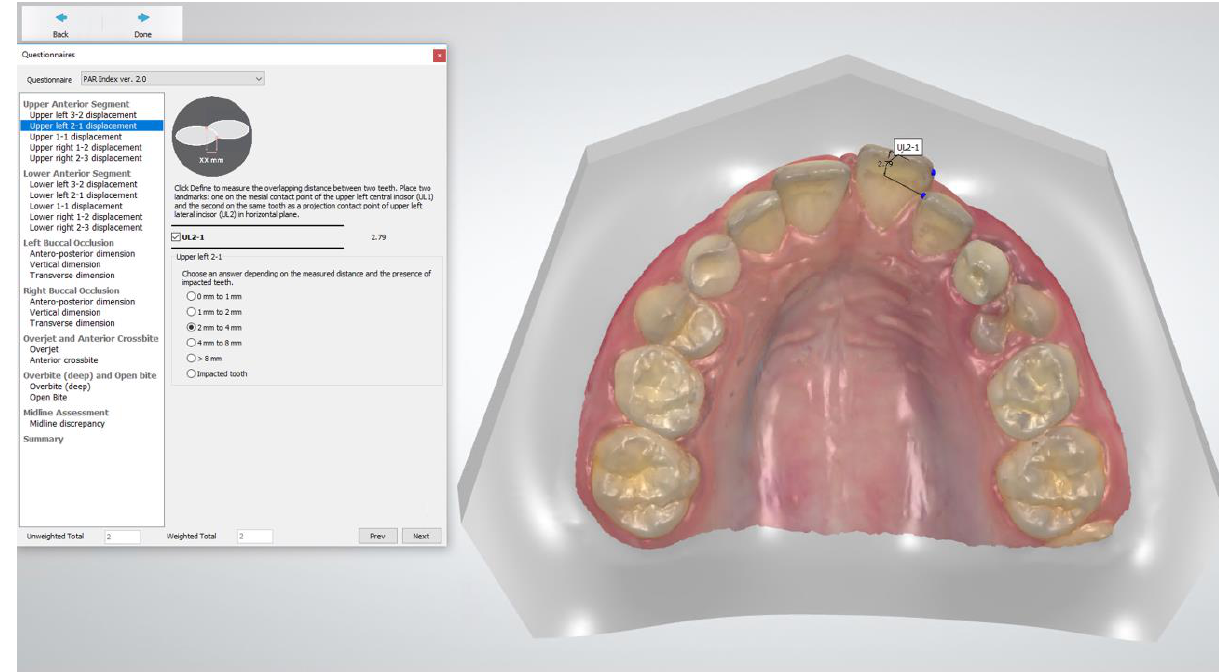
Figure 1. Peer Assessment Rating (PAR) index scoring using Ortho Analyzer software. Anterior component scoring contact point displacement between teeth 21 and 22.